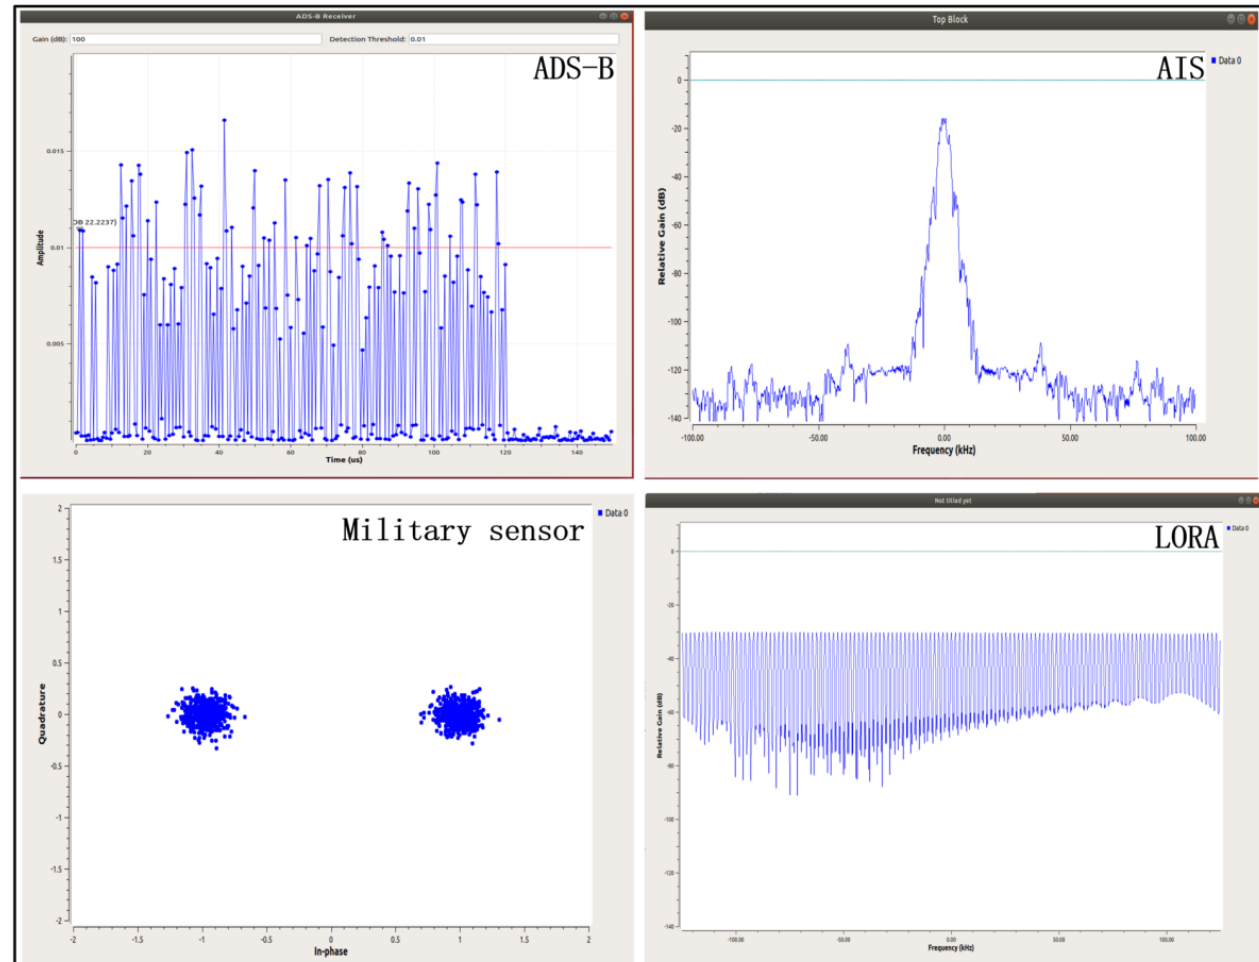
Figure 15. The simulation results of various GRC flows.